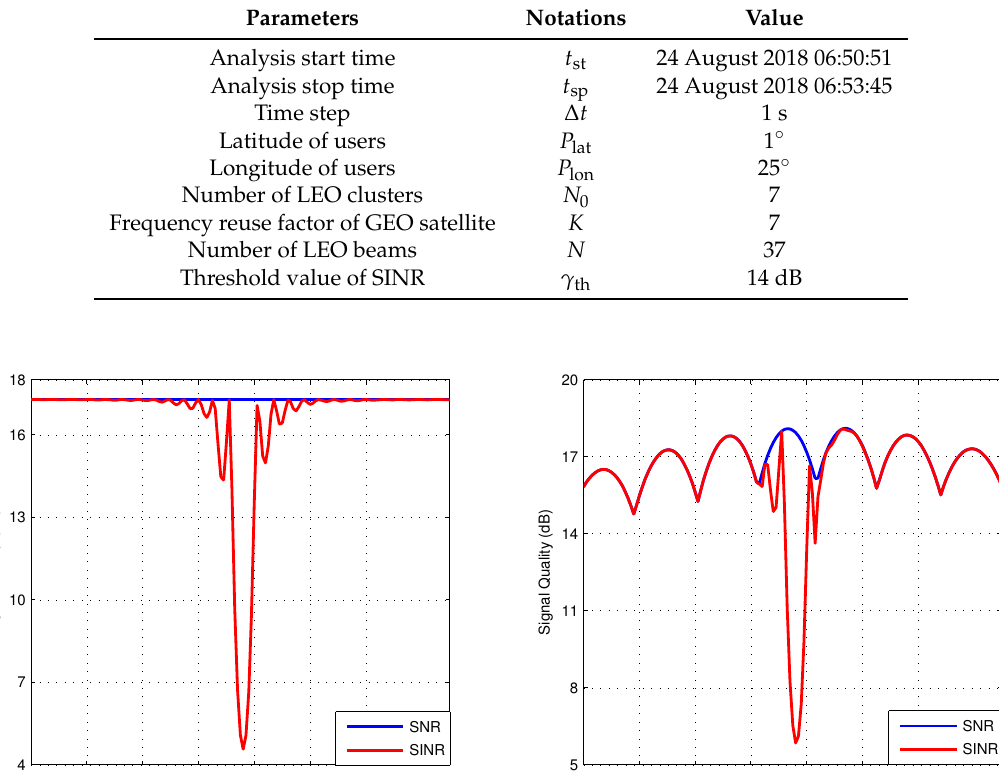
Table 3. Simulation parameters.